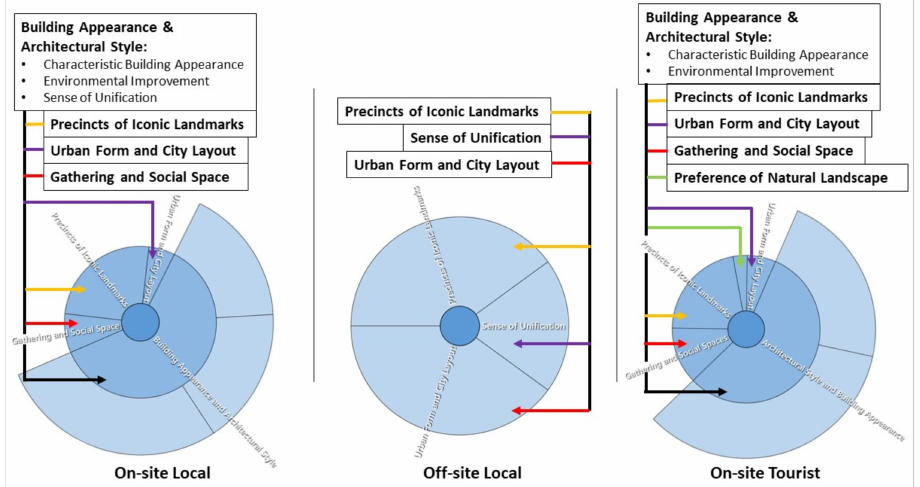
Figure 7. Results and categories—building and